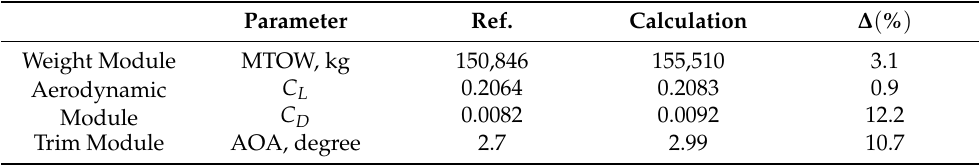
Table 2. Weight, aerodynamics, and trim validation with SAX-40 [21]. Parameter